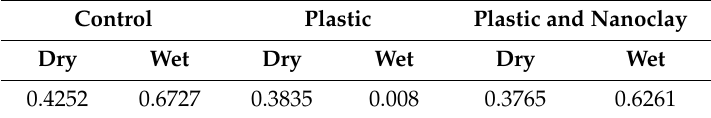
Table 3. One-way ANOVA ( p -values).